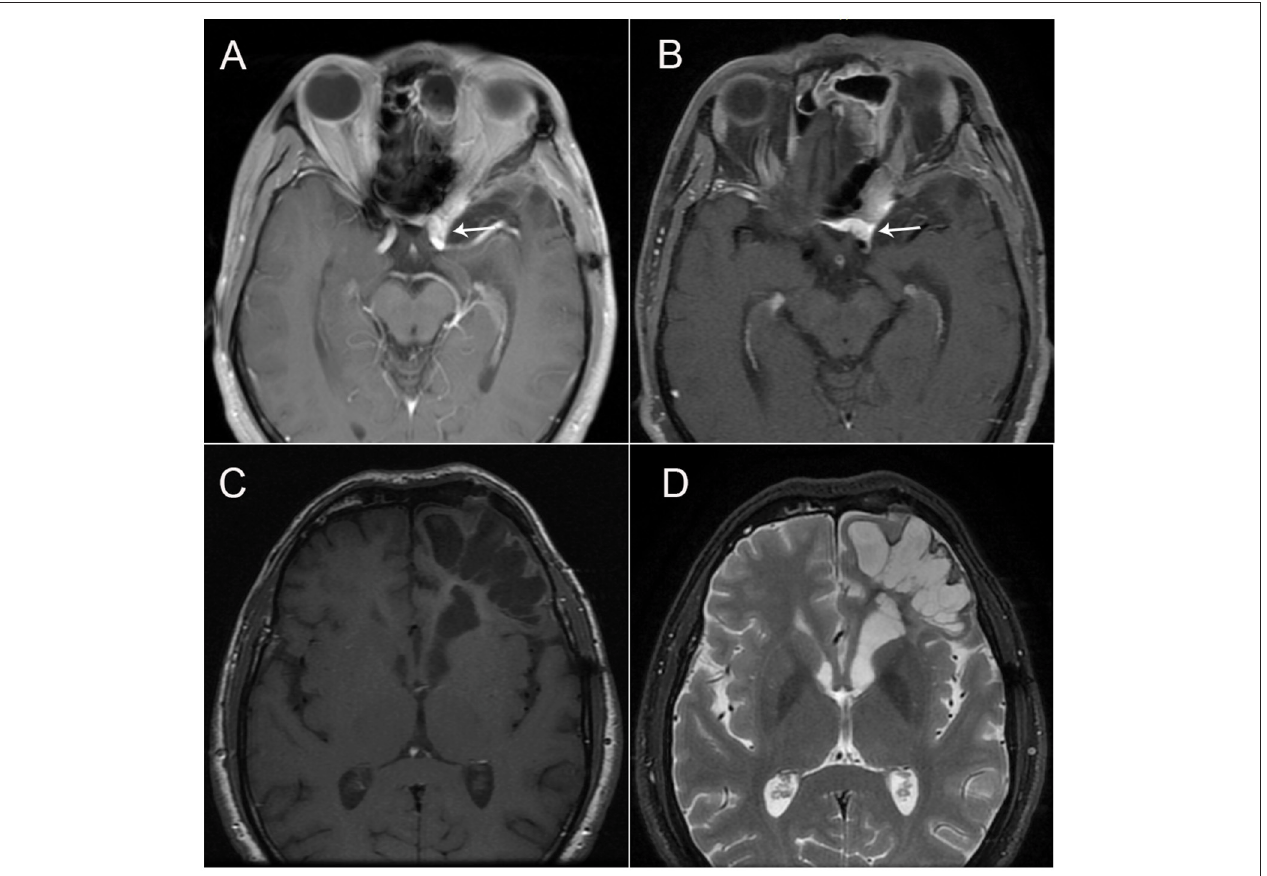
FIGURE 2 | (A) Brain magnetic resonance imaging (MRI; T1-weighted sequence after gadolinium enhancement) showing the fusiform thickening of the localized dura mater in the left frontal-temporal lobe, which is vividly enhanced with contrast; (B) Brain MRI (T1-weighted sequence) showing the fusiform thickening of the localized dura mater in the left frontal-temporal lobe. (C,D) Brain MRI (T1- and T2-weighted sequence) showing a large area of softening lesion and glial hyperplasia in the left frontal-temporal lobe.